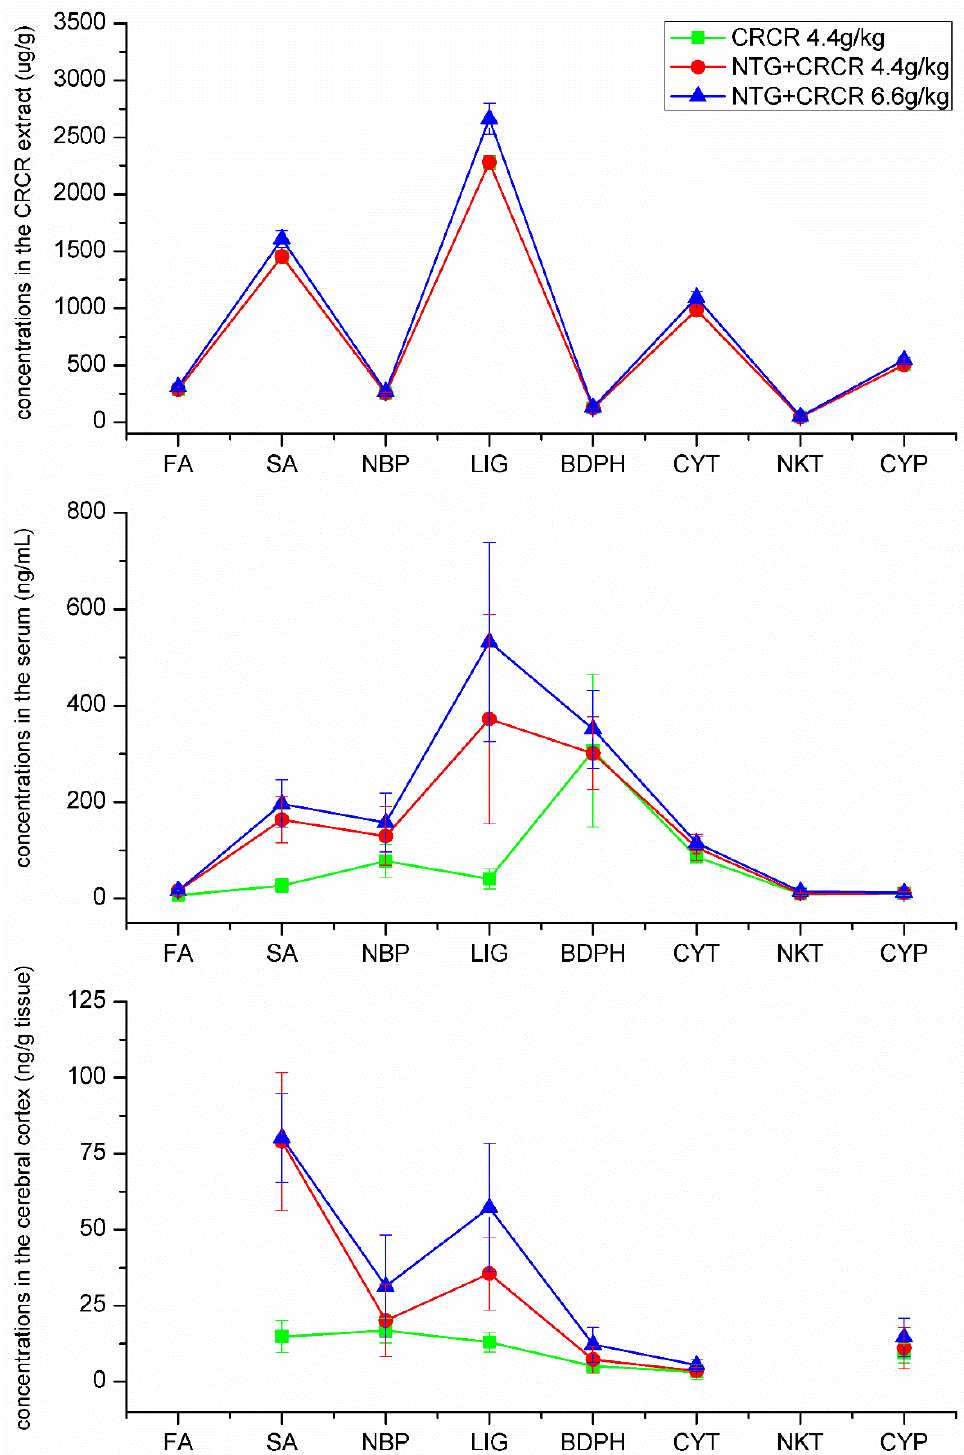
Figure 6. The concentrations of the analytes in the CRCR extract, rat serum and rat cerebral cortex determined by UPLC-MS/MS.